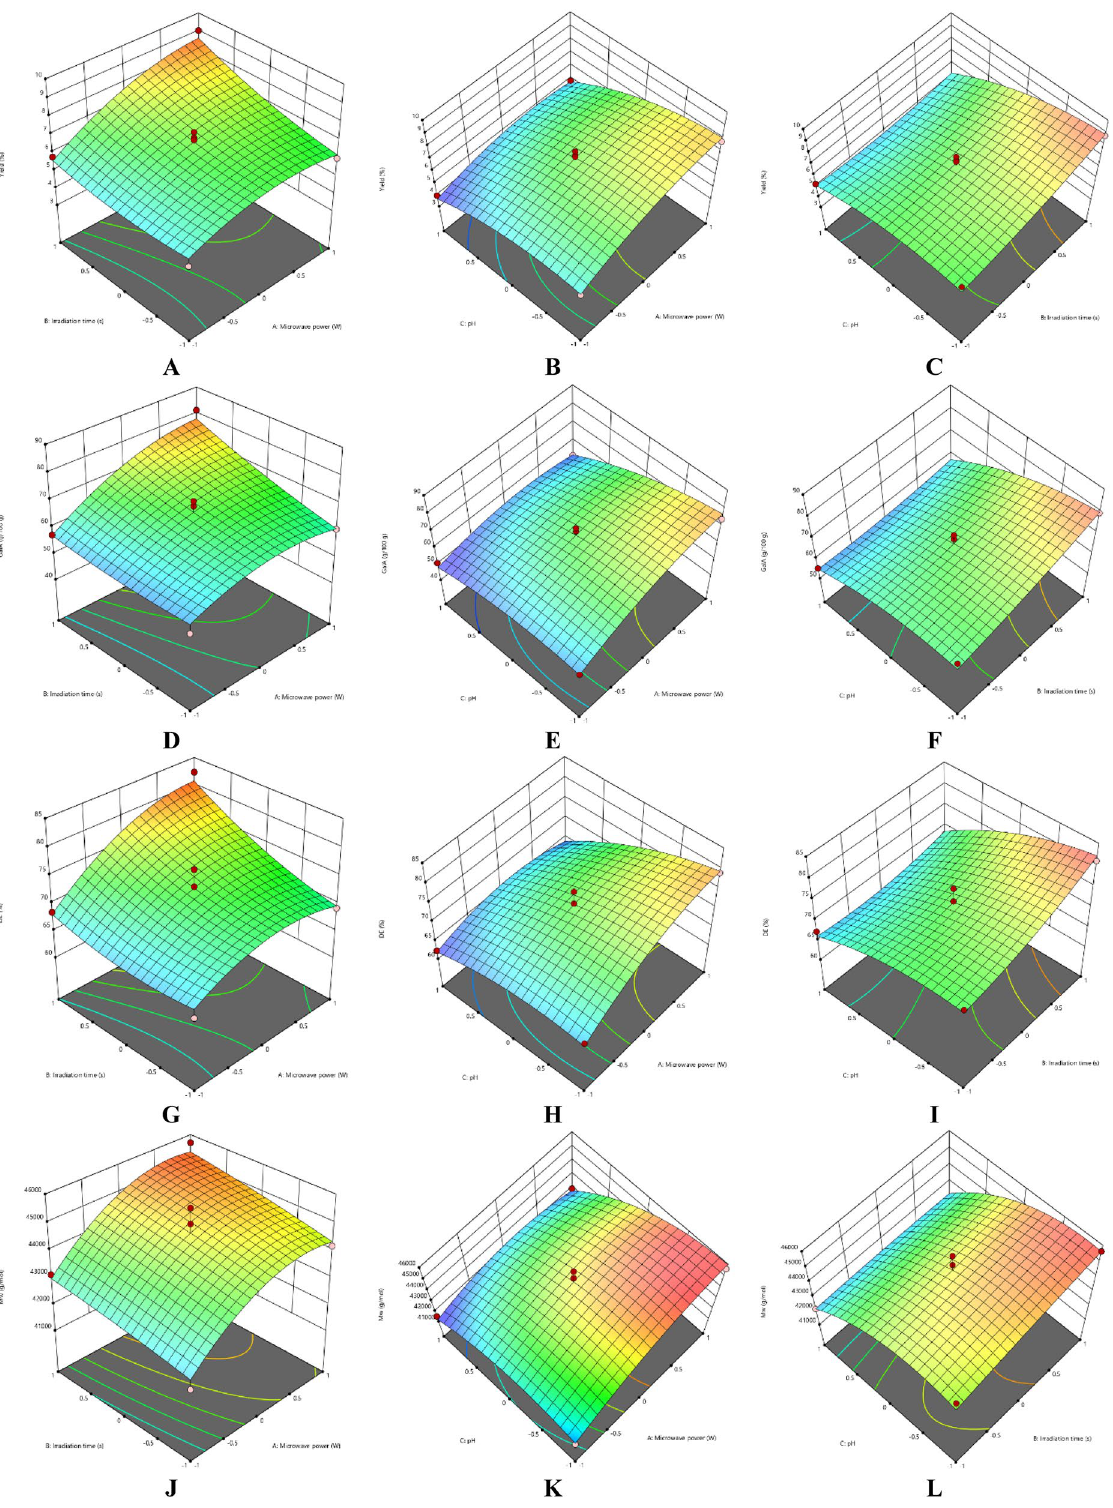
Figure 1. 3D graphs showing the influence of extraction parameters on the yield ( A–C ), GalA content ( D–F ), DE ( G–I ) and M w ( J–L ) for FN